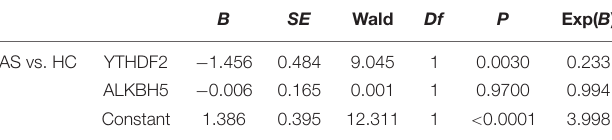
TABLE 3 | The mRNA expression of YTHDF2 and ALKBH5 in